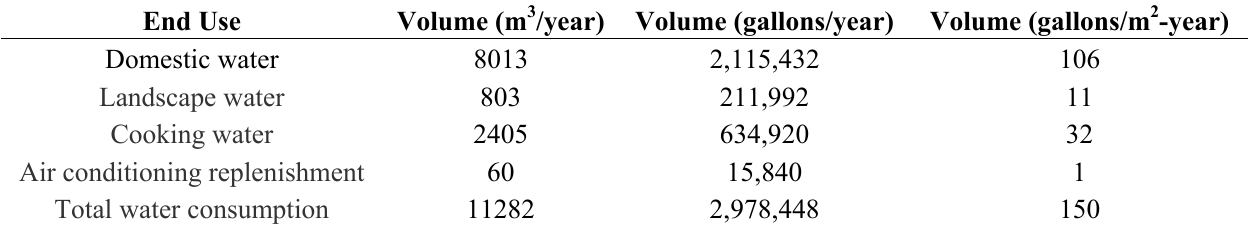
Table 5. Annual water consumption by end uses (cooling, landscaping, etc .) for 2011.